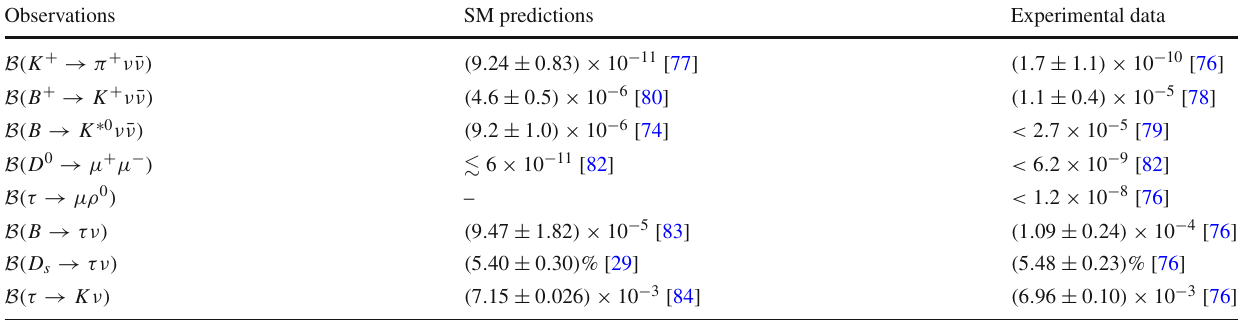
Table 1 Current status of the related processes, which can be affected by RPV-MSSMIS at tree level. The experimental upper limits are given at the 90% CL Observations SM predictions Experimental